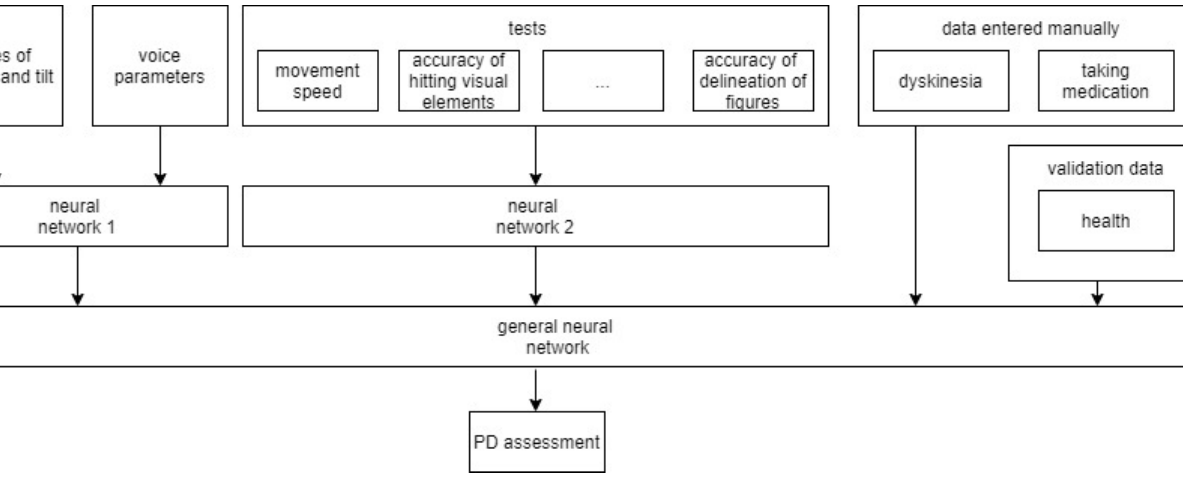
Figure 1. General architecture of a system of neural networks for PD analysis. The original neural network architecture for rotation angles and voice parameters is shown in Figure 2.